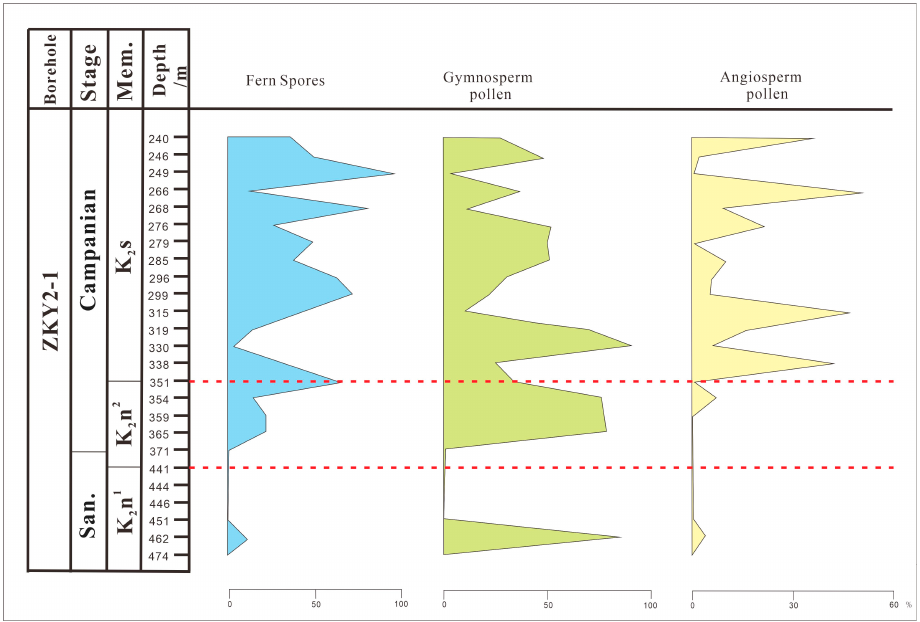
Figure 5. Variation trend in percentage of the palynomorphs from K 2 n 1+2 to K 2 s in borehole ZKY2-1.